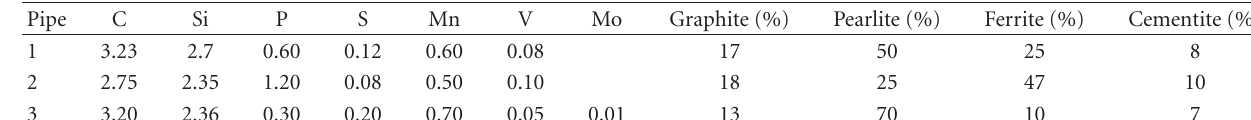
Table 3: Chemical composition of cast iron.